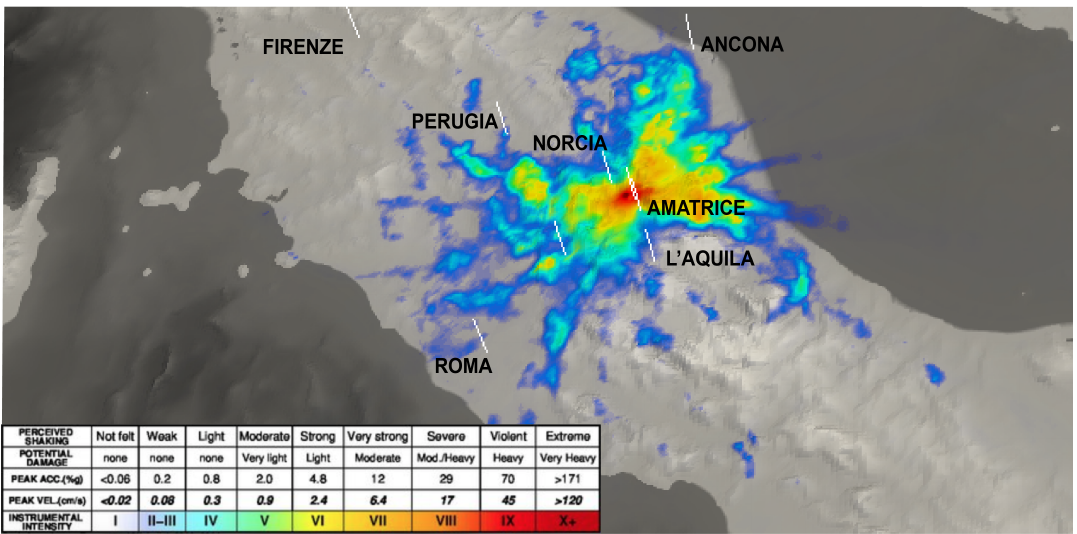
Figure 3: 3D synthetic ground motion shakemap obtained with point source TDMT moment tensor, velocity model of [Di Stefano & Ciaccio, 2014], SRMT30 topography. The comparison with the ground motion data in the epicentral area requires simulation with a finite fault model of the seismic source. Unfortunately, it need additional time to be determined so it is not available for fast simulations with communication